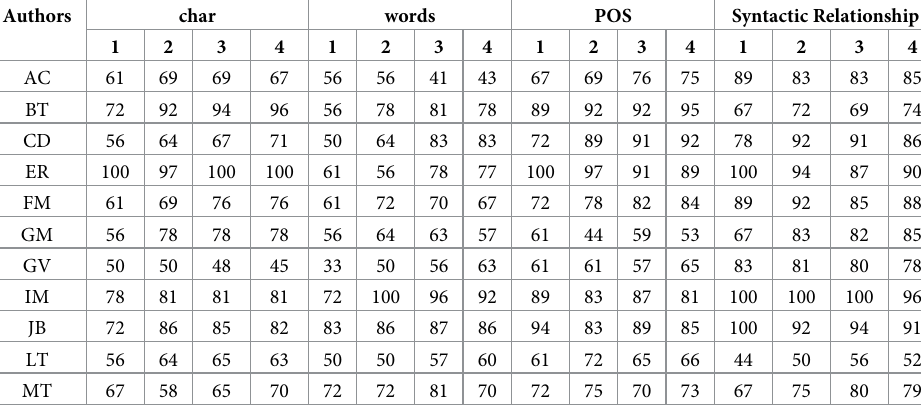
Table 10. Accuracy using LSA-features (1, 2, 3, 4 are split settings).